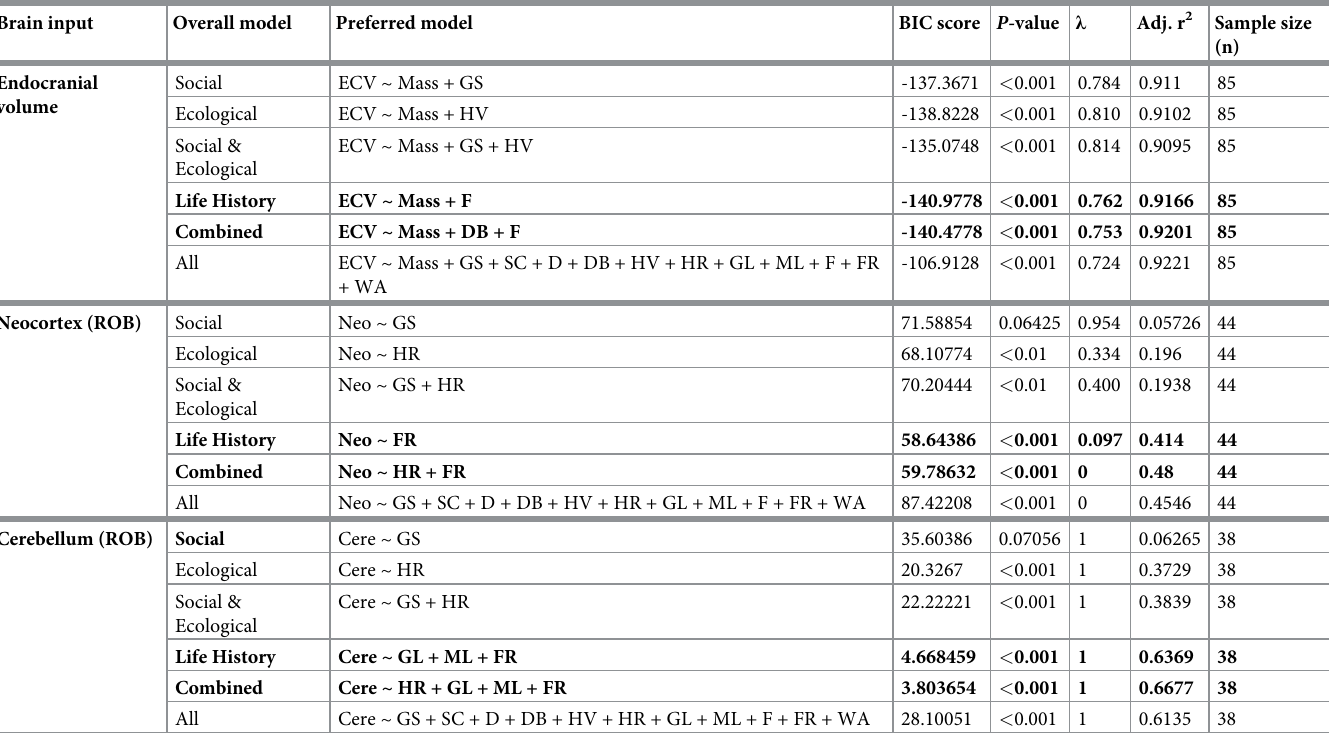
Table 3. Phylogenetic generalised least-squares (PGLS) regression analyses examining the effects of social, ecological and life-history variables � on carnivoran whole and regional brain volumes. Preferred models represent the ‘ best fit ’ model (with the lowest BIC score) of the overall model category (i.e., social or ecological). The combined models represent the ‘ best fit ’ model after running all combinations of the previous ‘ best fit ’ models (models one to four). Boldness indicates the model(s) with the lowest BIC score across all models (dBIC < 2).